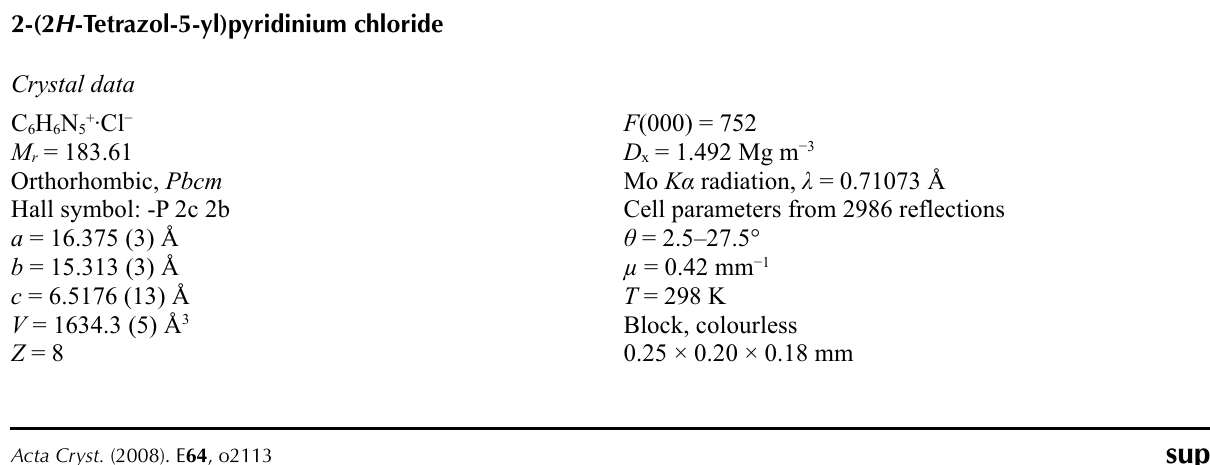
The crystal packing of the title compound viewed along the c axis showing the two-dimensionnal hydrogen bondings